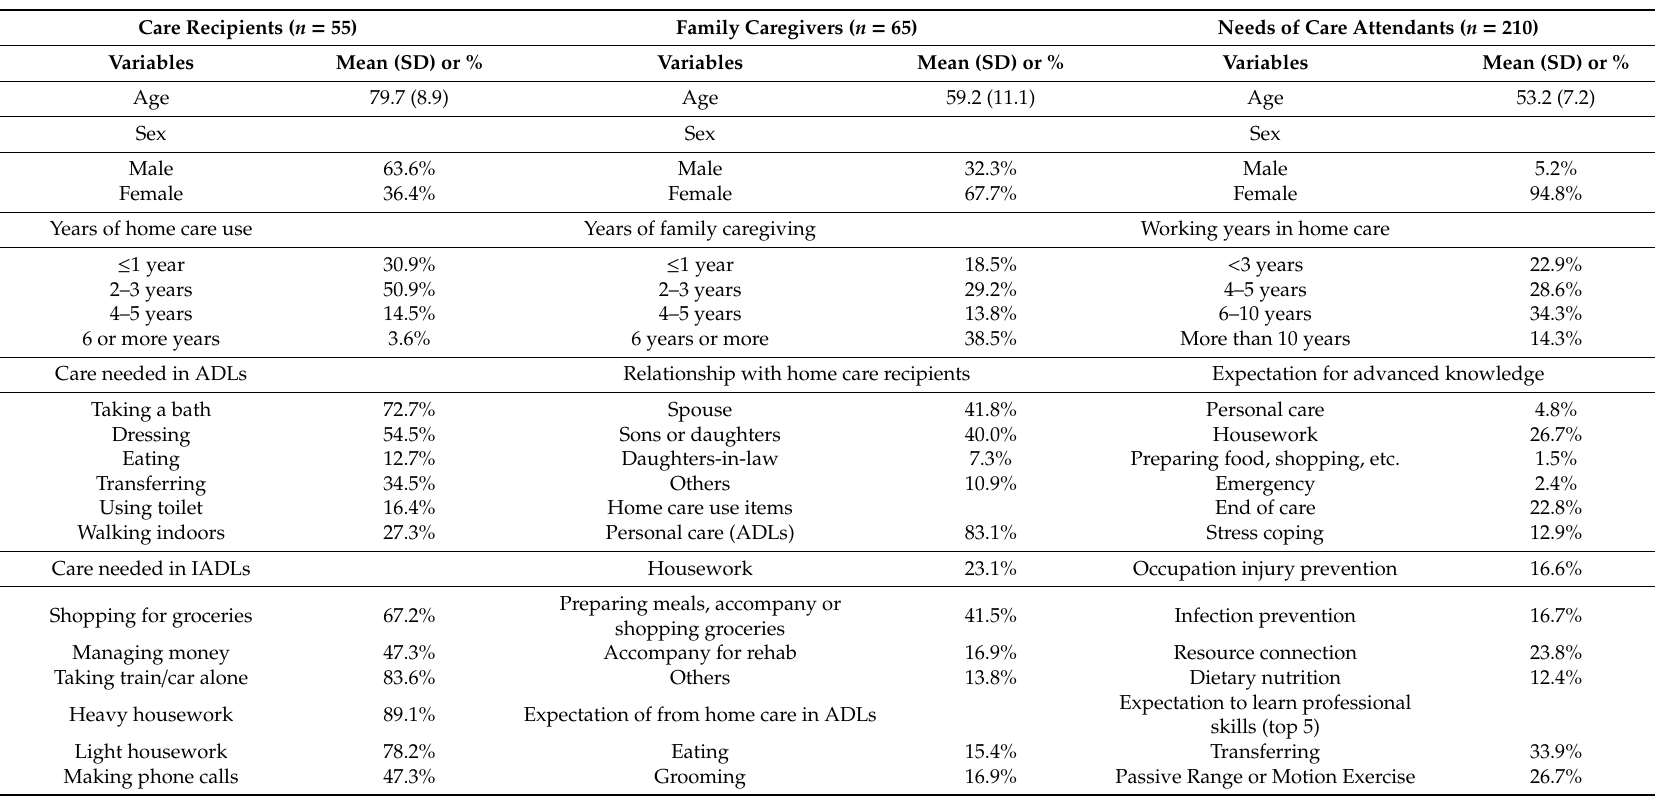
Table 1. Needs assessment of the reablement home care items reported by care recipients, family caregivers, and care